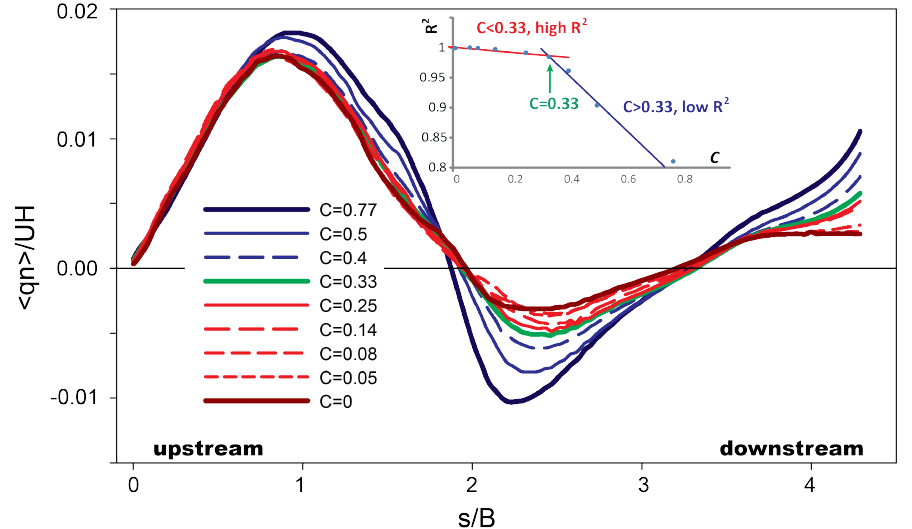
Figure 6. Transverse unit discharge averaged over the transverse direction. The inset shows the R 2 of transverse unit discharge < q n / UH > between each curvature, C, and the straight channel condition (C = 0, R 2 = 1); a lower R 2 suggests greater hydraulic complexity for transverse unit discharge. The distribution of transverse unit discharge, q n / UH , were also largely insensitive to curvature, where C = 0.77, 0.33, and 0 each experienced a pronounced transport to the outer bank (positive values) upstream of the apex and transport to the inner bank further downstream (Figure 5). The impact of bed topography was noted in the damped oscillation patterns of q n / UH with the maximum leftward mass transport at 1 s / B , just upstream of the point bar, and rightward transport at about 2.3 s / B , downstream of the pool. As curvature increased the single ovate shaped hot-spot of